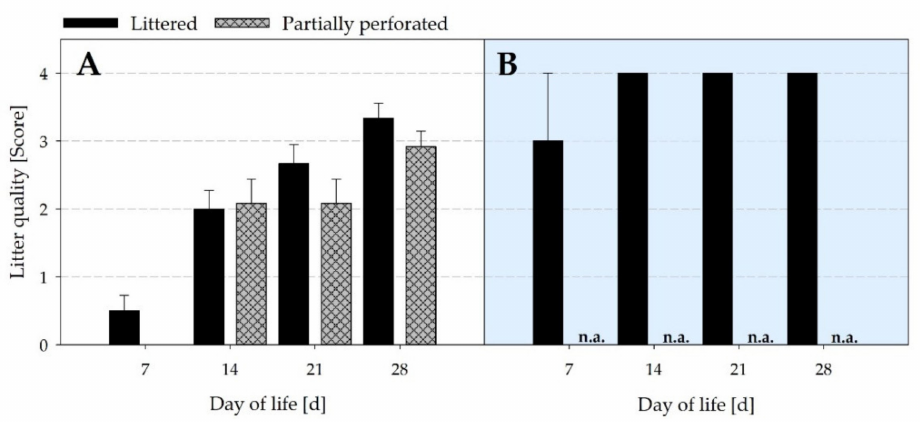
Figure 12. Mean scores of litter quality from ( A ) the littered side areas ( n = 12 values per day and barn) and ( B ) the supply area ( n = 3 values per day and barn) from broiler houses with two different floor types. n.a. = not assessed (no litter quality assessment underneath the perforated area in the supply area of the experimental